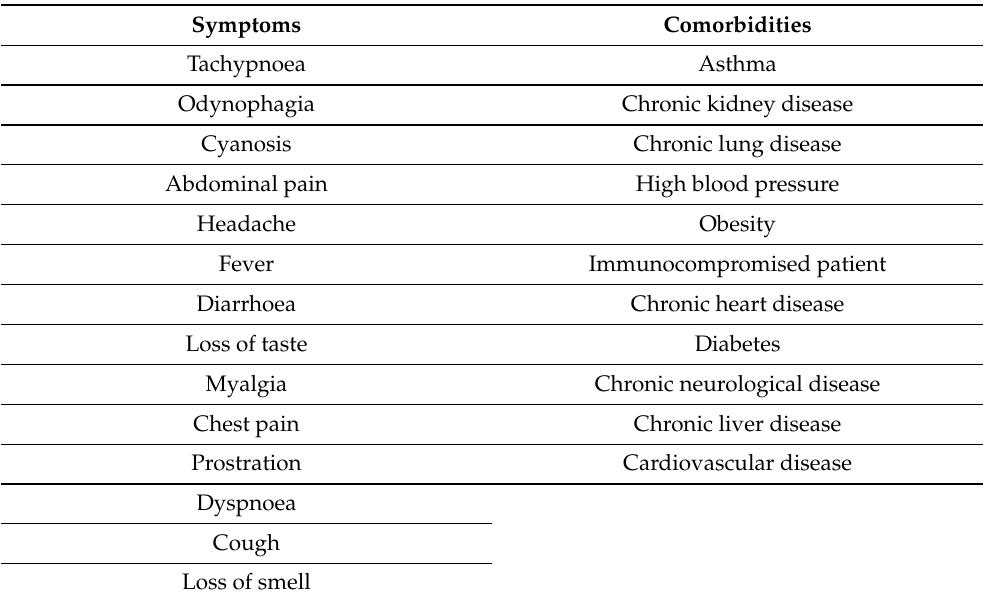
Table 1. Symptoms and comorbidities used in our